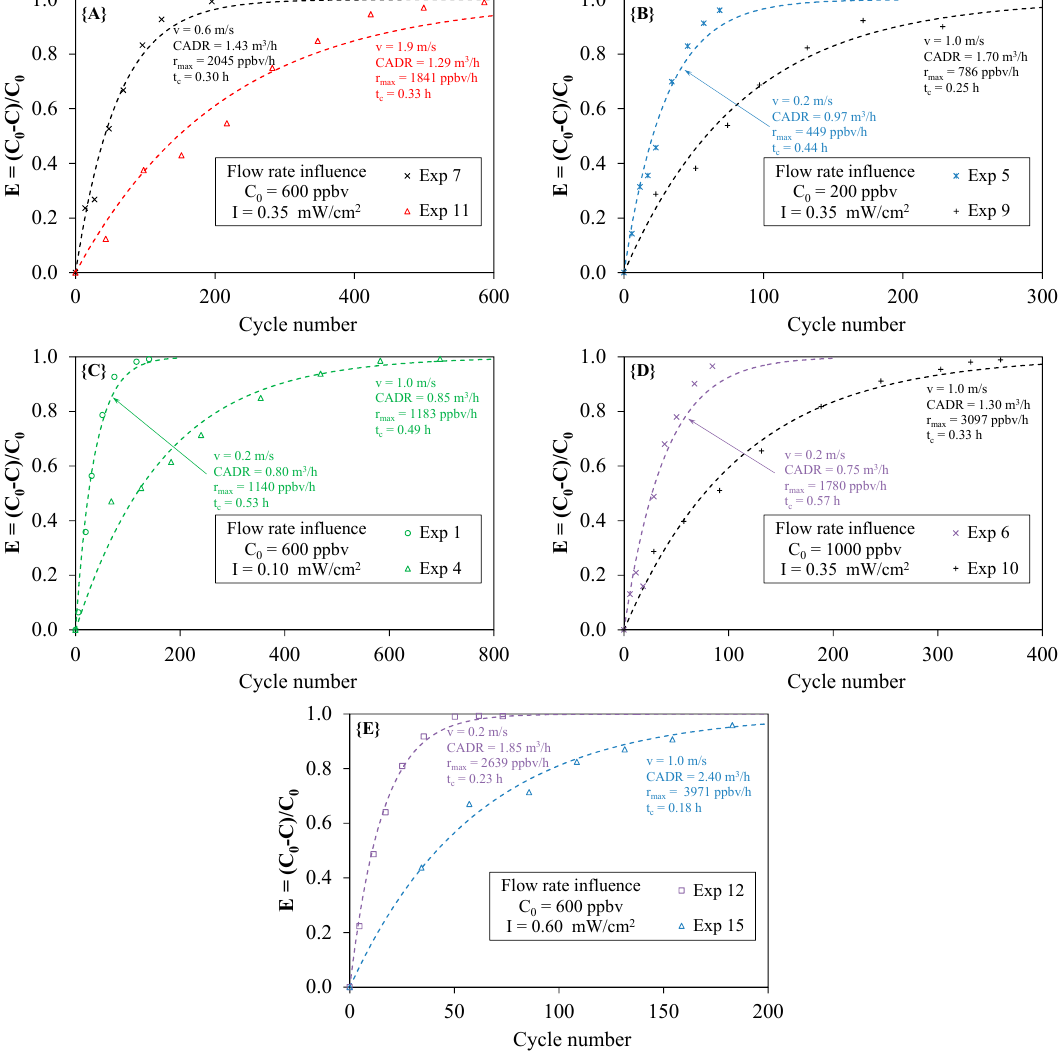
Figure 7. Flow rate influence on toluene removal efficiency according to the initial concentration C 0 and the light irradiance I (cases {A} – {E} ; experimental points and model; cycle number = 1/ α ).